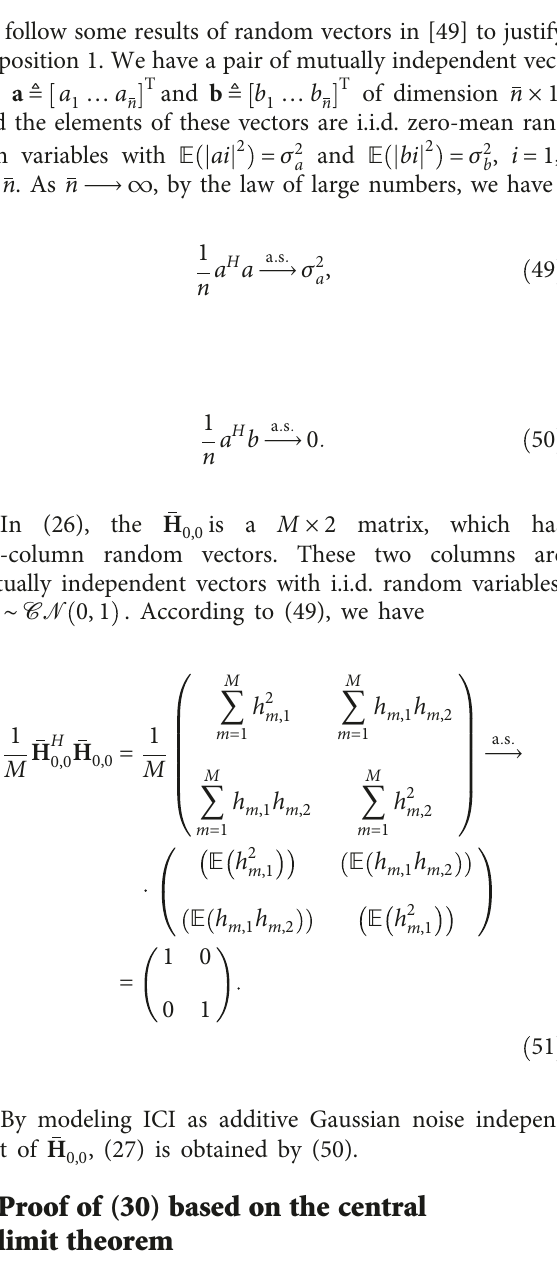
Figure 10: The ergodic capacity comparison between the joint scheme and TU scheme for the massive MIMO-OFDM uplink system. χ = 1